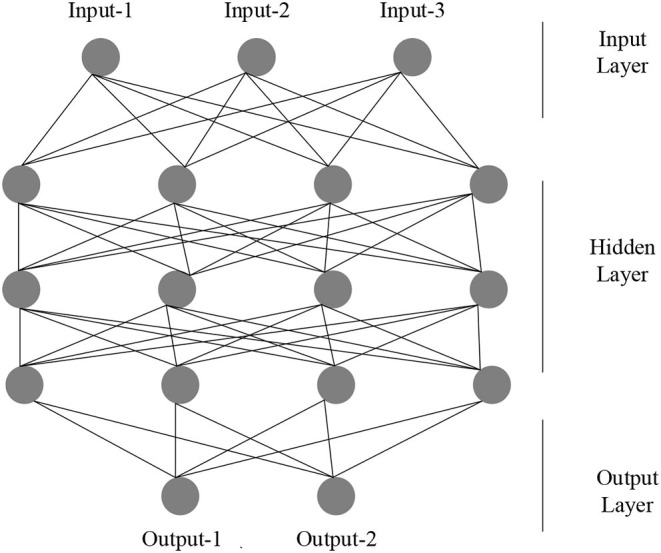
Structure of ANN.